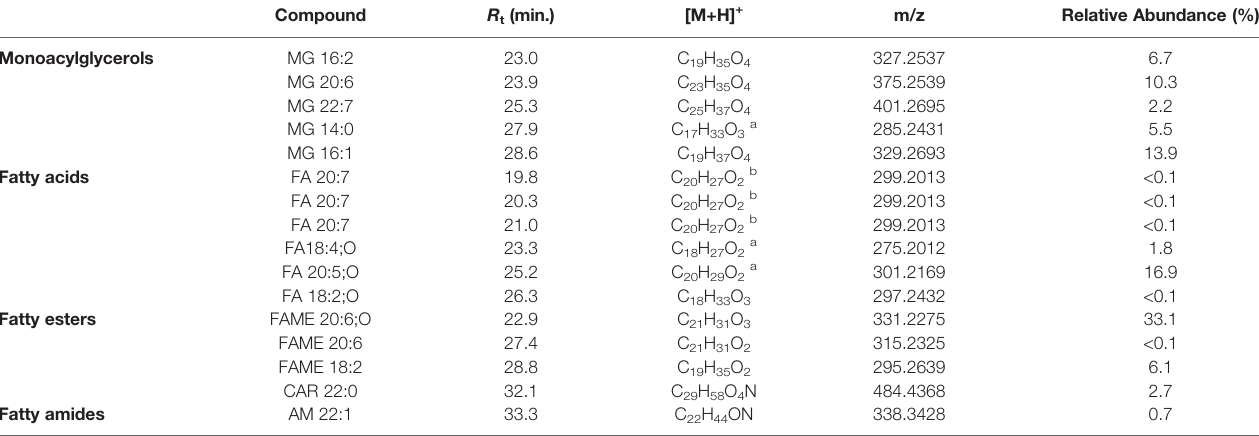
TABLE 6 | Monoacylglycerols and fatty acids and derivatives identi fi ed in the organic extract from B. niger . Compound R t (min.)